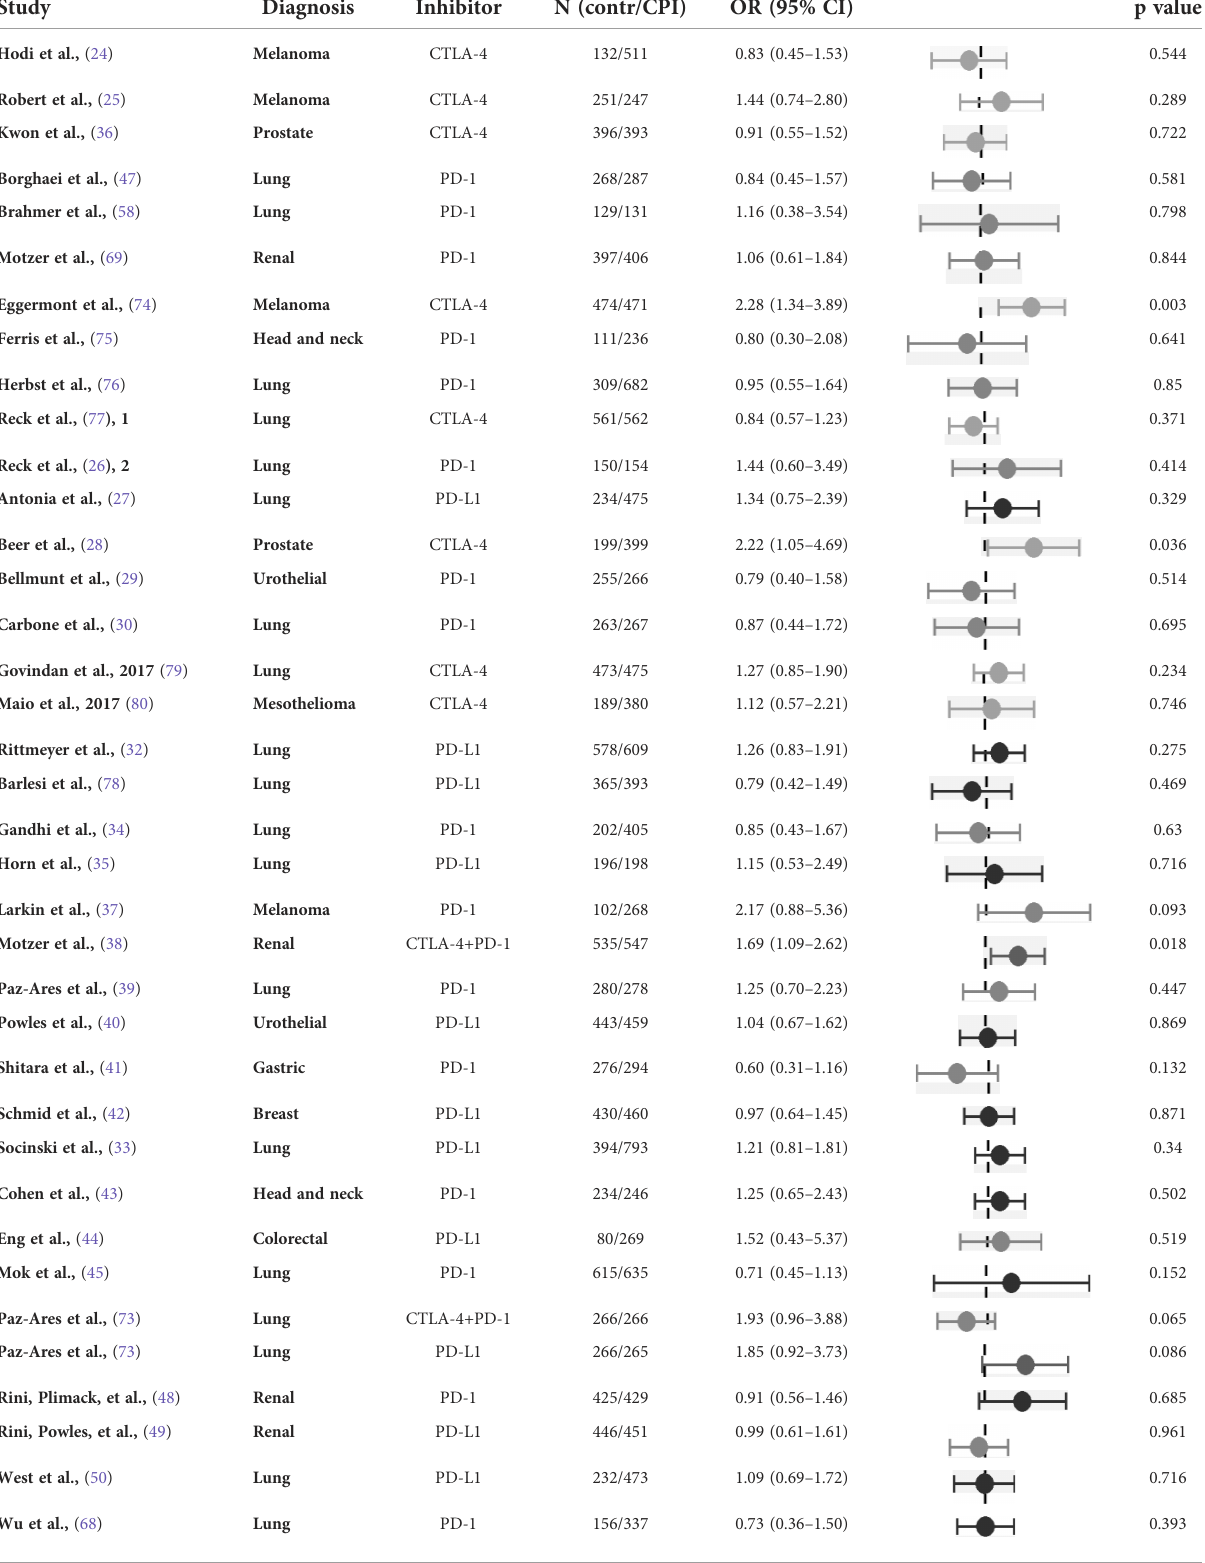
TABLE 2 Odds ratio of insomnia in randomised studies of checkpoint inhibitors versus all types of control (control arm as